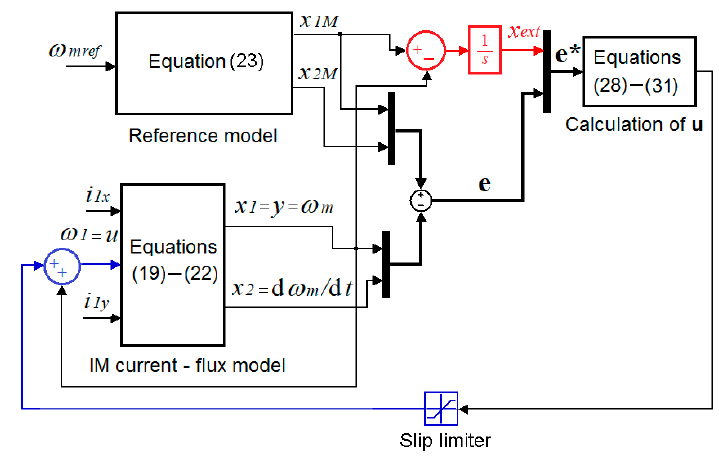
Figure 4. IM drive block diagram.